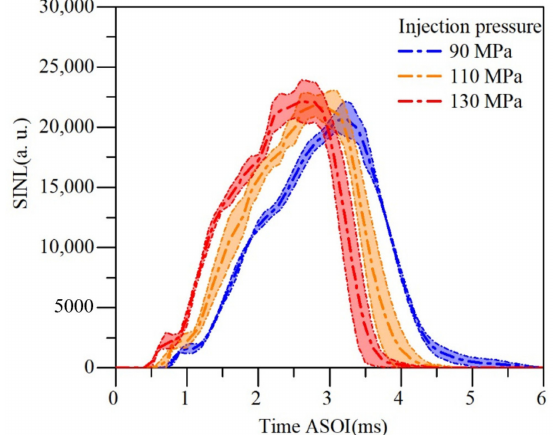
Figure 15. The flame spatial integral nature luminosity (SINL).